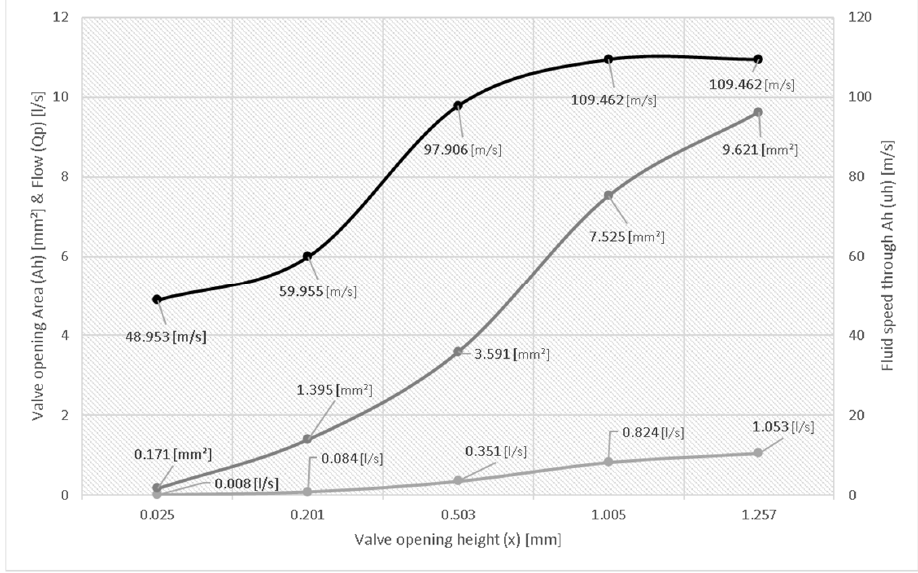
Figure 5. Opening area, flow and velocity of the fluid through the valve − 50 (°C).